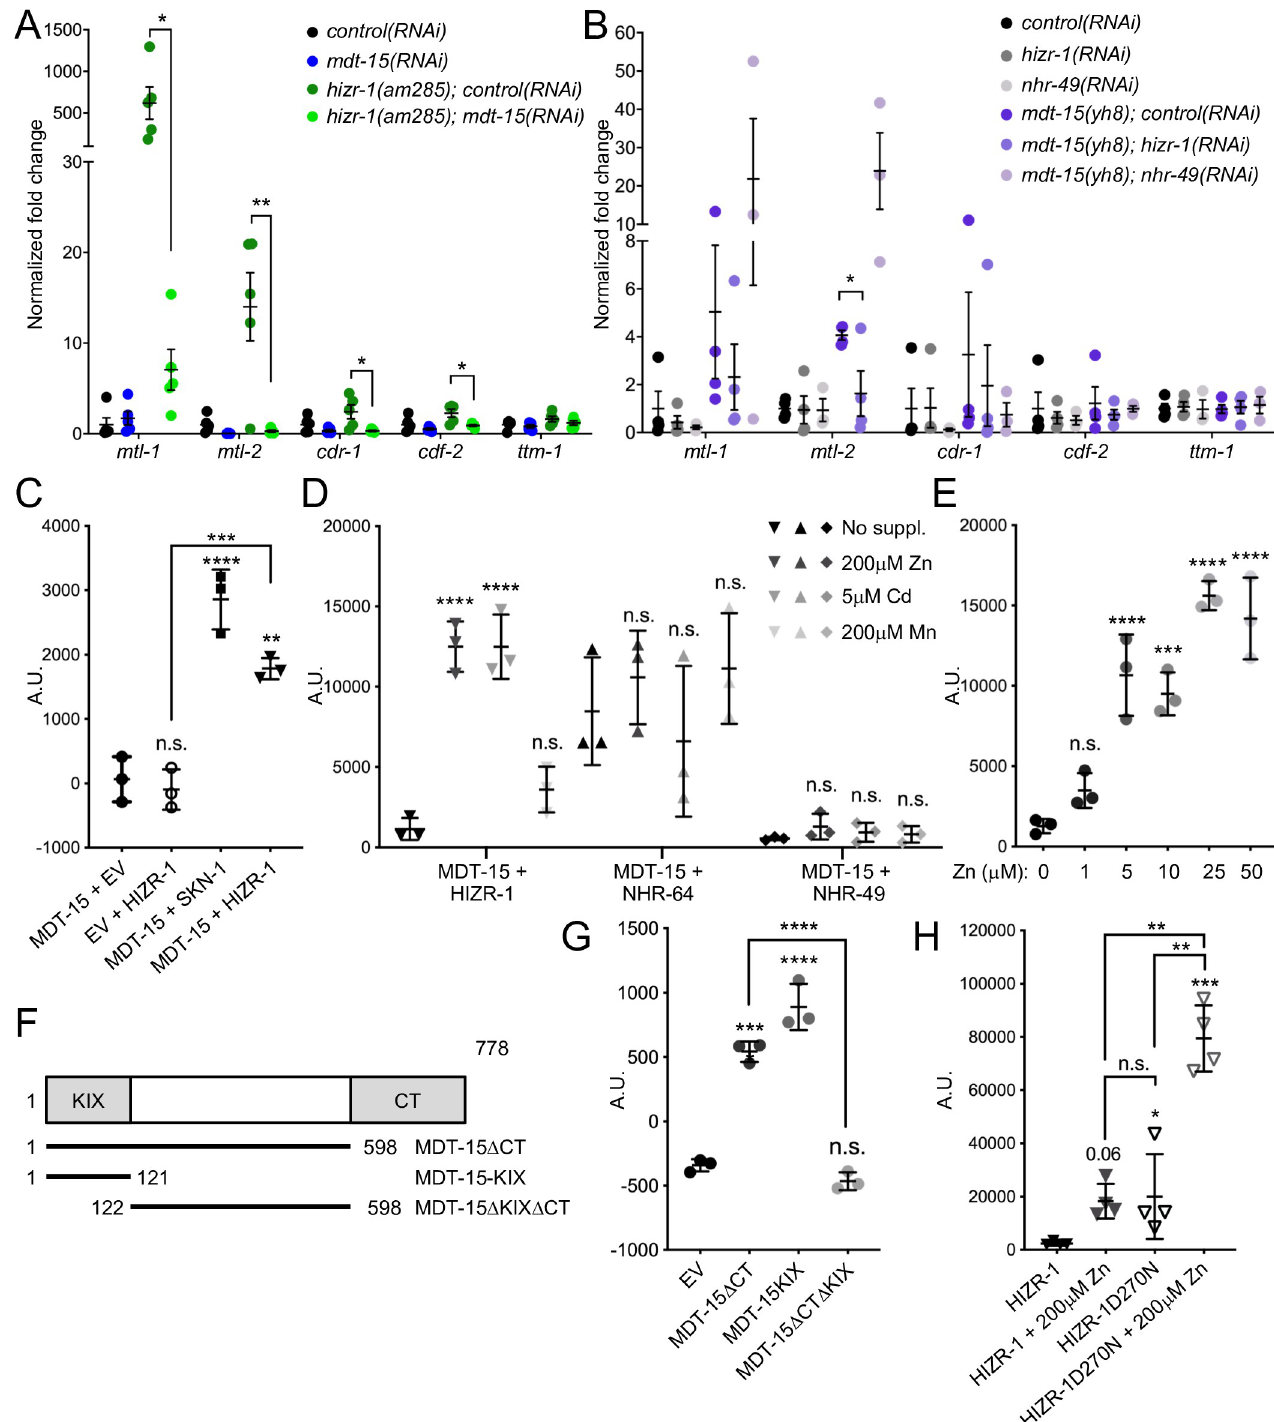
Fig 4. MDT-15 and HIZR-1 are co-dependent for metal responsive gene induction and physically bind in cadmium and zinc-enhanced fashion. [A-B] qRT-PCR analysis of zinc and cadmium-responsive genes. The graphs show fold-inductions of mRNAs normalized to the average of wild-type control(RNAi) worms. Error bars: SEM. Statistical analysis: � p < 0.05, �� p < 0.01, unpaired Student’s t-test for indicated comparisons. [A] Comparison of wild-type and hizr- 1(am285) gf worms grown on control or mdt-15 RNAi (n = 5 independent repeats). [B] Comparison of wild-type and mdt-15(yh8) gf worms grown on control, hizr-1 , or nhr-49 RNAi (n = 3–4 independent repeats). [C-E] Protein-protein interaction analysis using the Y2H system. Graphs show average interaction strength (arbitrary units, A.U.). Error bars: standard deviation. [C] Interaction between MDT-15 and HIZR-1, with Empty Vector (EV)–HIZR-1 and MDT-15–